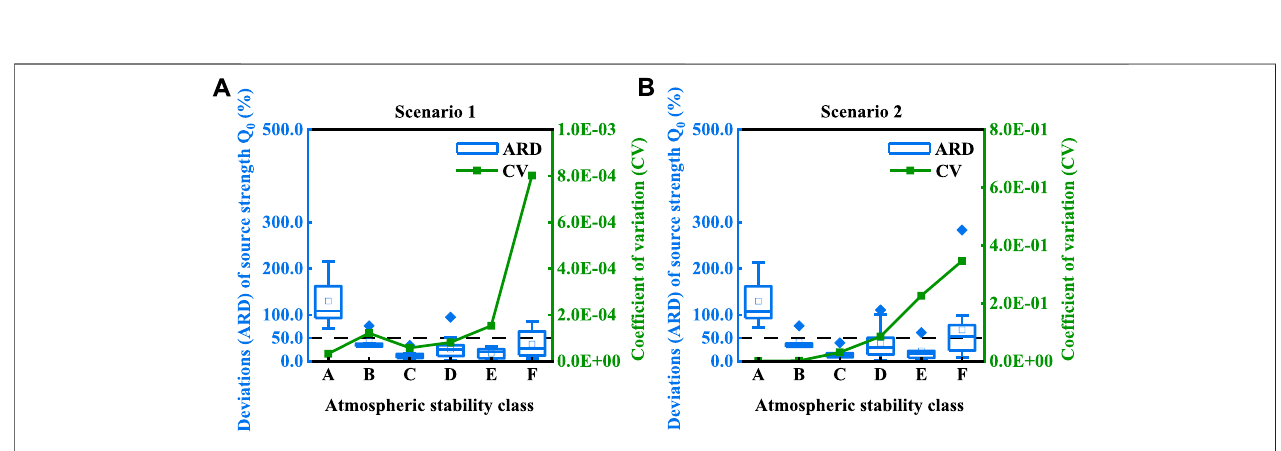
FIGURE4| Boxplotsoftheinversionaccuracyindex(ARD)andlinechartsoftheinversionrobustnessindex(CV)forsourcestrength(Q 0 )estimationunderdifferent application scenarios: (A) Scenario 1: only estimating source strength (Q 0 ), and (B) Scenario 2: estimating source strength (Q 0 ) and release height (z 0 ).